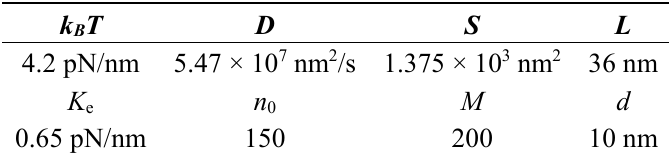
Table 1. Key parameters used in the